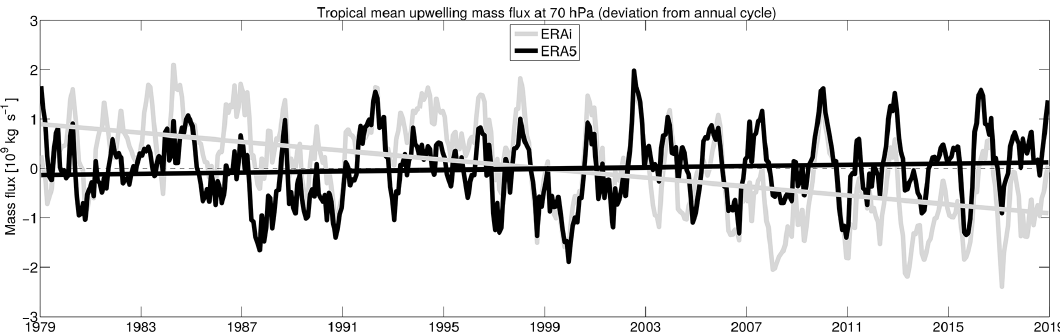
Figure 13. Time series of deseasonalized annual mean tropical upwelling mass flux at 70hPa ( ∼ 19km ) from the ERA5 and the ERA- Interim reanalyses for the 1979–2018 time period. Shown are ascending flux from the ERA-Interim reanalysis (light grey), ascending flux from the ERA5 reanalysis (black), linear trend of the ascending flux from the ERA-Interim (light grey), and linear trend of the ascending flux from the ERA5 reanalysis (black) for the 1979–2018 time